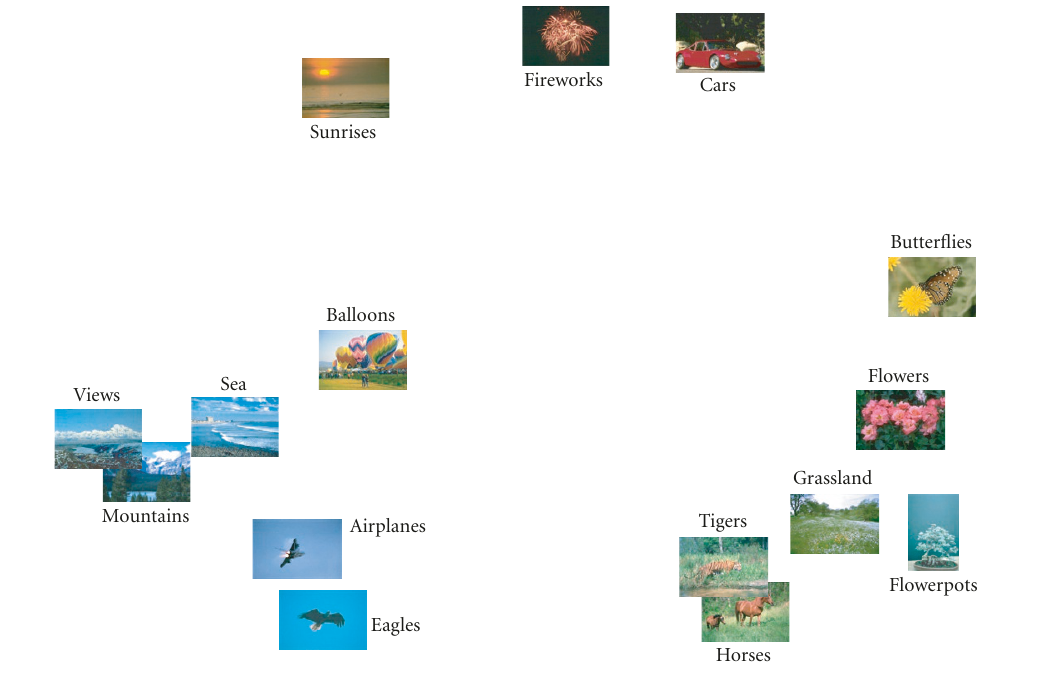
Figure 3: 2D biplot reflecting the perceptual di ff erences between the class